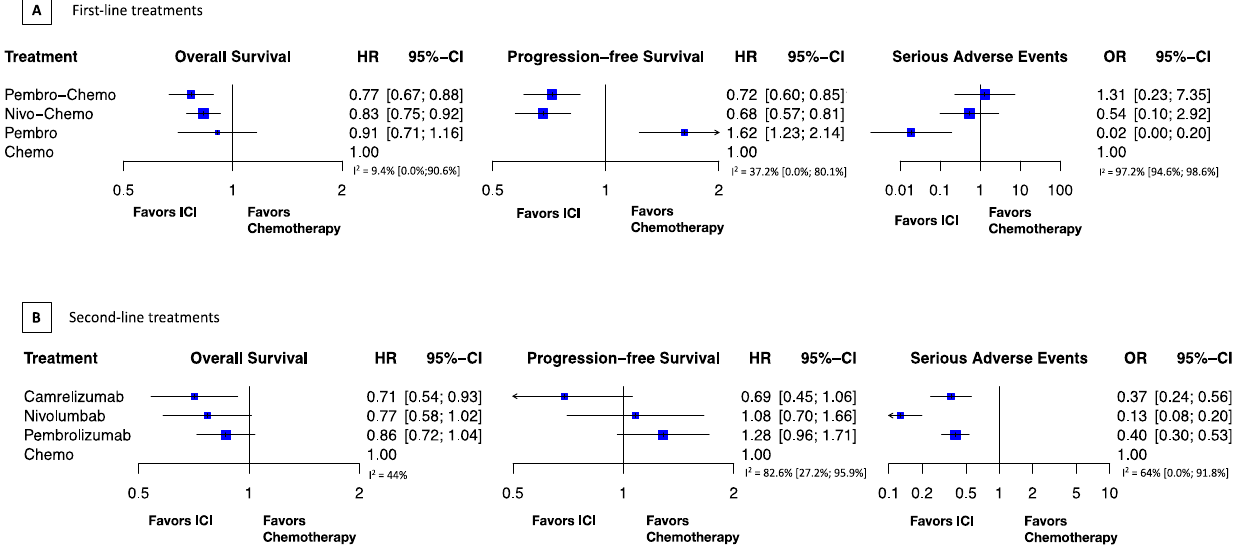
Figure 1. Relative treatment effects. HR indicates hazard ratio; ( A ). First-line treatments; ( B ). Second-line treatments; OR, odds ratio; CI, confidence interval. Treatment abbreviations: Chemo indicates chemotherapy; Pembro, pembrolizumab;